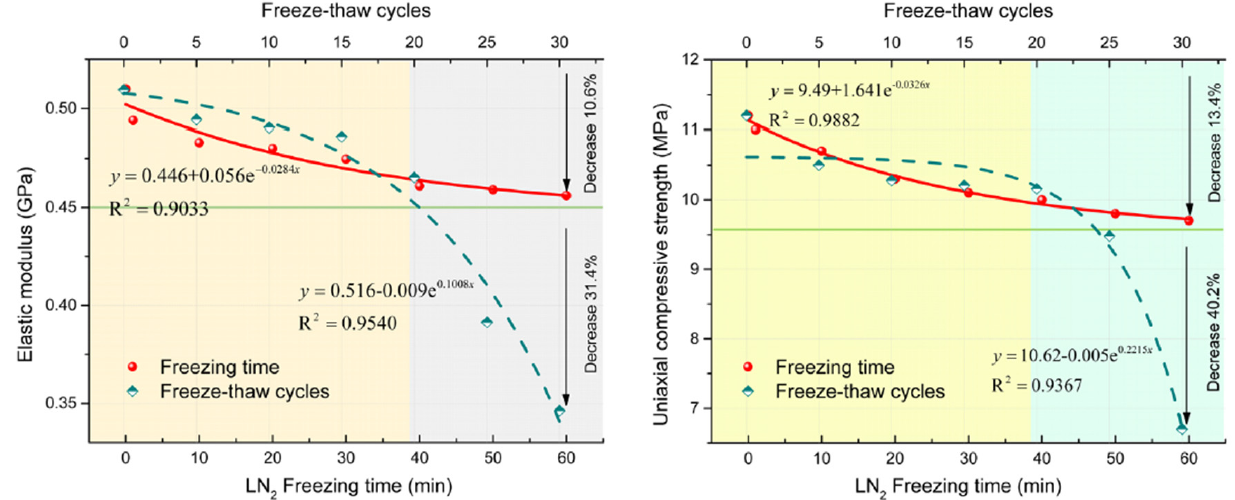
Figure 3. Changes in the elastic modulus and compressive strength after freezing–thawing cycles.